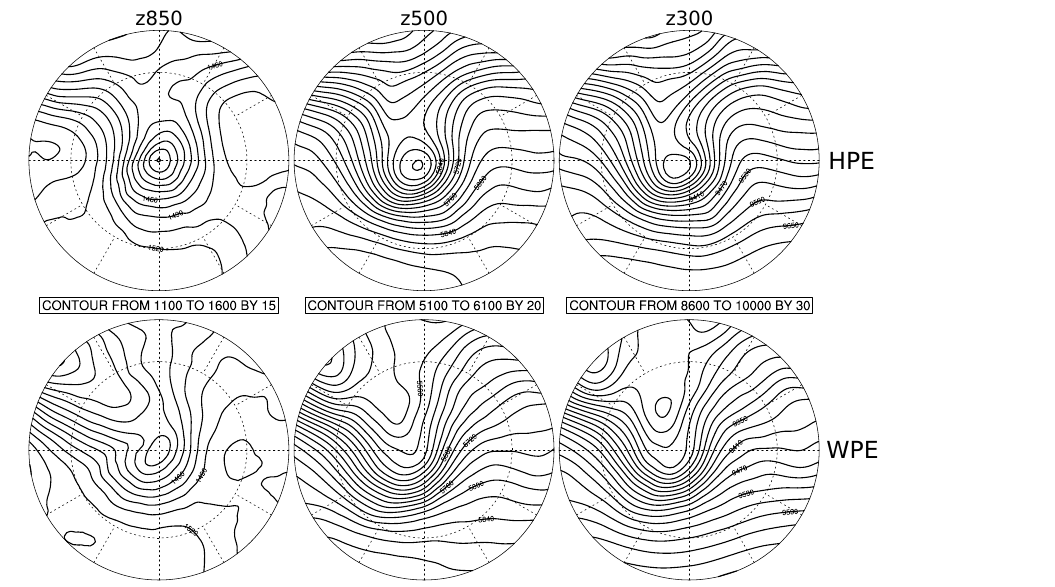
Figure 9. Average geopotential height at 850hPa (left column panels), 500hPa (centre column panels) and 300hPa (right column) for the time step with maximum precipitation of all HPEs (upper row panels) and WPEs (bottom row panels). The distance from the centre of the composite cyclone to the edge is 23 ◦ .